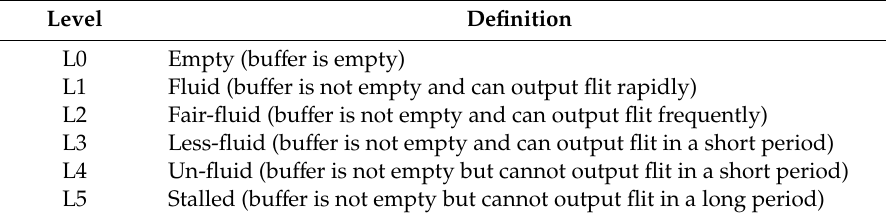
Table 1. Bu ff er Fluidity Level (BFluL).